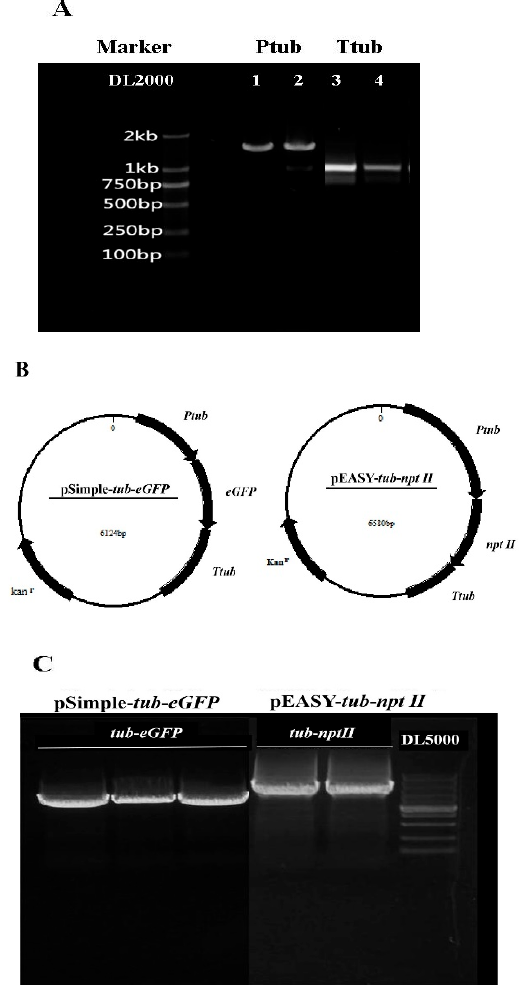
Figure 2. Construction of pSimple- tub-eGFP and pEASY- tub-nptII vectors. ( A ) Gel analysis of tub promoter and terminator. ( B ) Design structure and size of pSimple- tub-eGFP and pEASY- tub-nptII vectors. ( C ) Gel analysis of pSimple- tub-eGFP and pEASY- tub-nptII vectors.